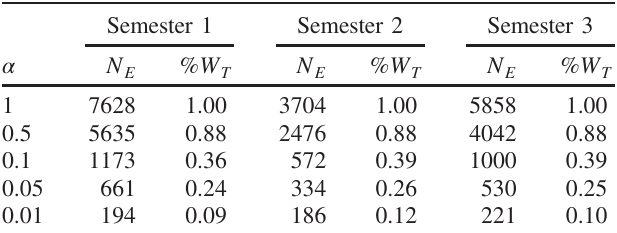
TABLE III. Edges ( N E ) and fraction of total original weight ( % W T ) at each level of backbone extraction; α ¼ 1 is the original network.